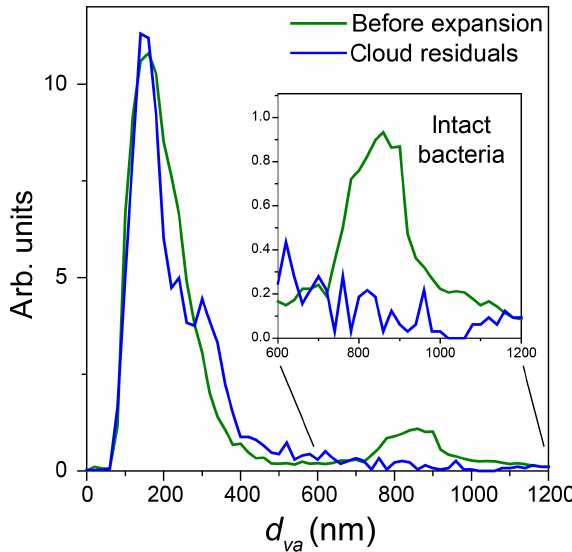
Figure 10. Normalized miniSPLAT-measured d va size distributions of PF CGina particles in the AIDA chamber before Expansion 2 (green) and of cloud residuals transmitted through the PCVI during the expansion (blue). The inset presents in expanded scale the size distributions of the intact bacteria, showing nearly no distinct peak for intact bacteria.